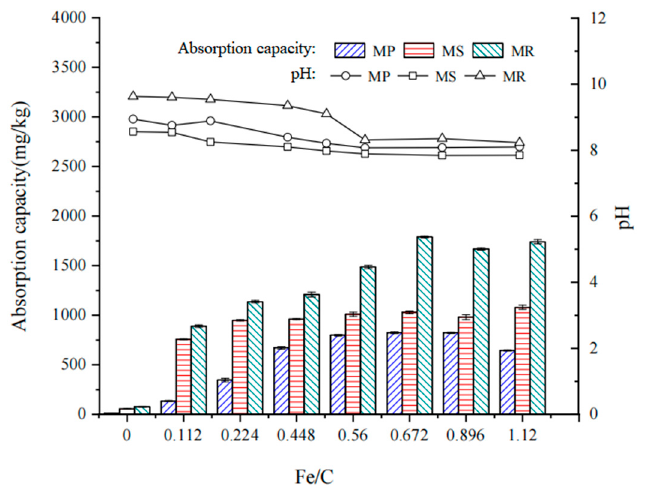
Figure 1. P removal efficiency of Fe-B and pH of the equilibrium solutions. Table 1. Physicochemical properties of biochars before and after